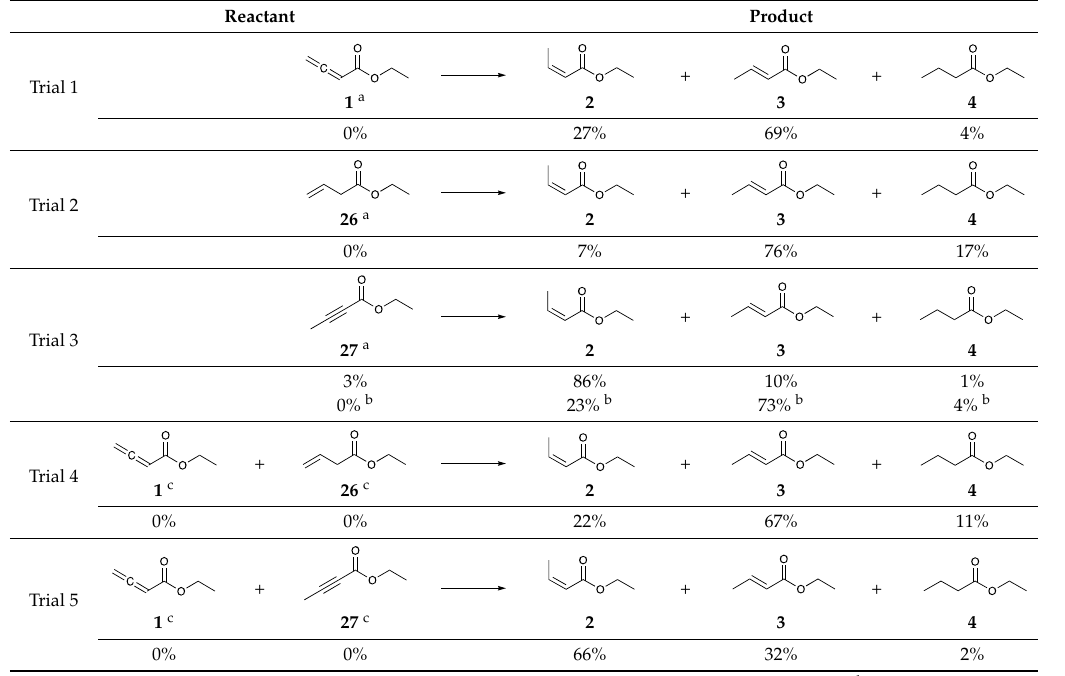
Table 4. The single-substrate and dual-substrates catalytic reaction of various unsaturated esters. Reactant